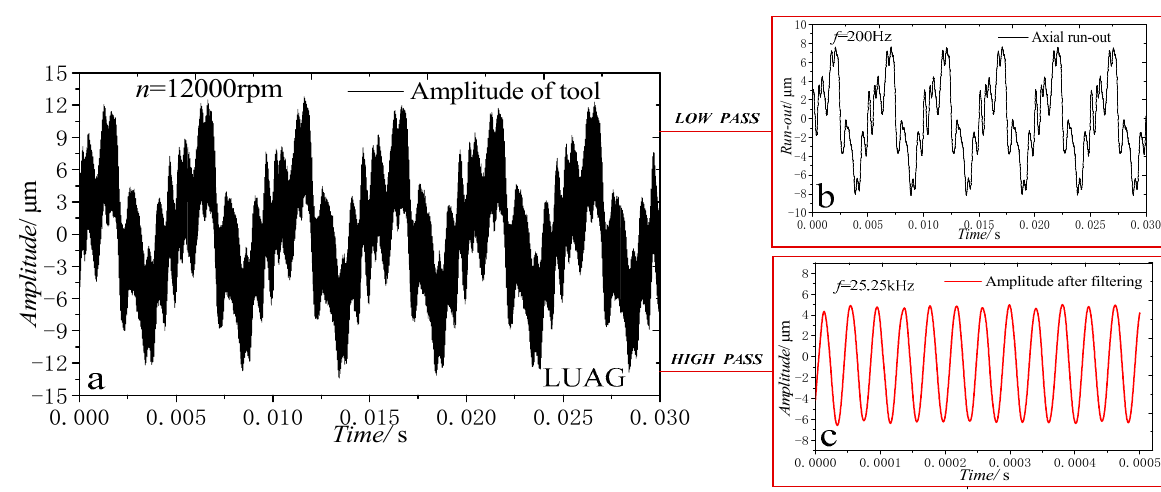
Figure 8. Ultrasonic amplitude of the tool with rotation: ( a ) overall curve, ( b ) axial run-out, ( c ) actual amplitude. To study the effects of the relative position of the eddy current sensor and the end face of the tool on the AA, the distance between the centre of the eddy current sensor and the tool centre was set at 1.5, 2.25, and 3 mm, as shown in Figure 9. When the rotational speed was 12,000 rpm, the amplitude of the distance at 1.5, 2.25, and 3 mm was 5.84, 6.09, and 5.74 µ m, respectively. The maximum error for all three of the amplitudes was 0.35 µ m, which was smaller than the measurement error of the eddy current sensor. The preceding research shows that, regardless of the relative position of the eddy current sensor and the tool, the eddy current sensor can effectively measure the amplitude of the end face of the tool. It also indicates that this method for measuring the AA exhibits universal applicability.